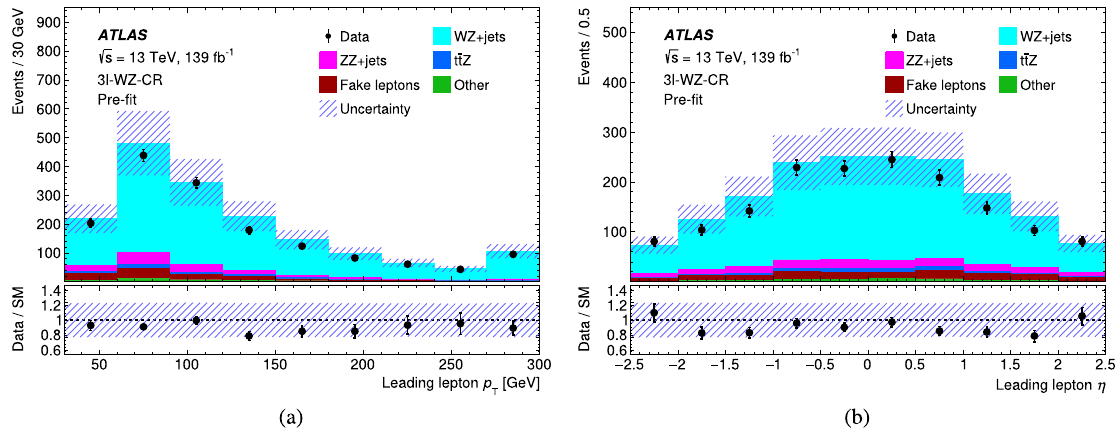
Fig. 1 Distribution of the a p T and b η of the leading lepton in the W Z + jets control region. The shaded band corresponds to the total uncertainty (systematic and statistical) of the total SM prediction. The lower panel shows the ratio of the data to the SM prediction. The results